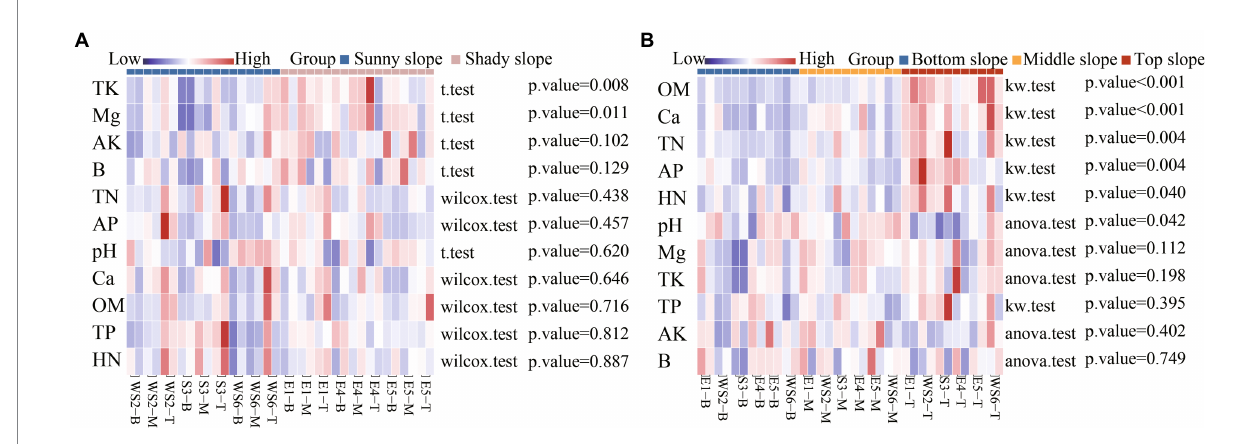
FIGURE 6 Correlation heatmap between soil properties and slope direction (A) and position (B)